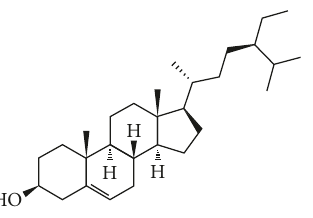
Figure 1: Structure of β